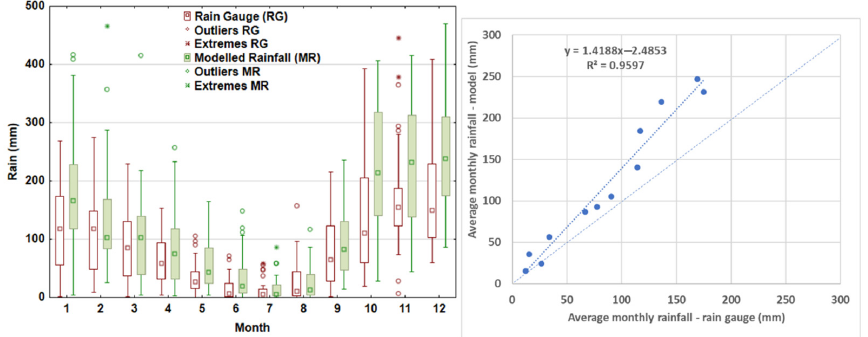
Figure 2. Comparison of monthly rainfall values from a rain gauge at Corfu airport and from the RACMO22E climate model for the period of 1971–2004. Table 2. Basic annual precipitation statistics for the reference period and climate scenarios .